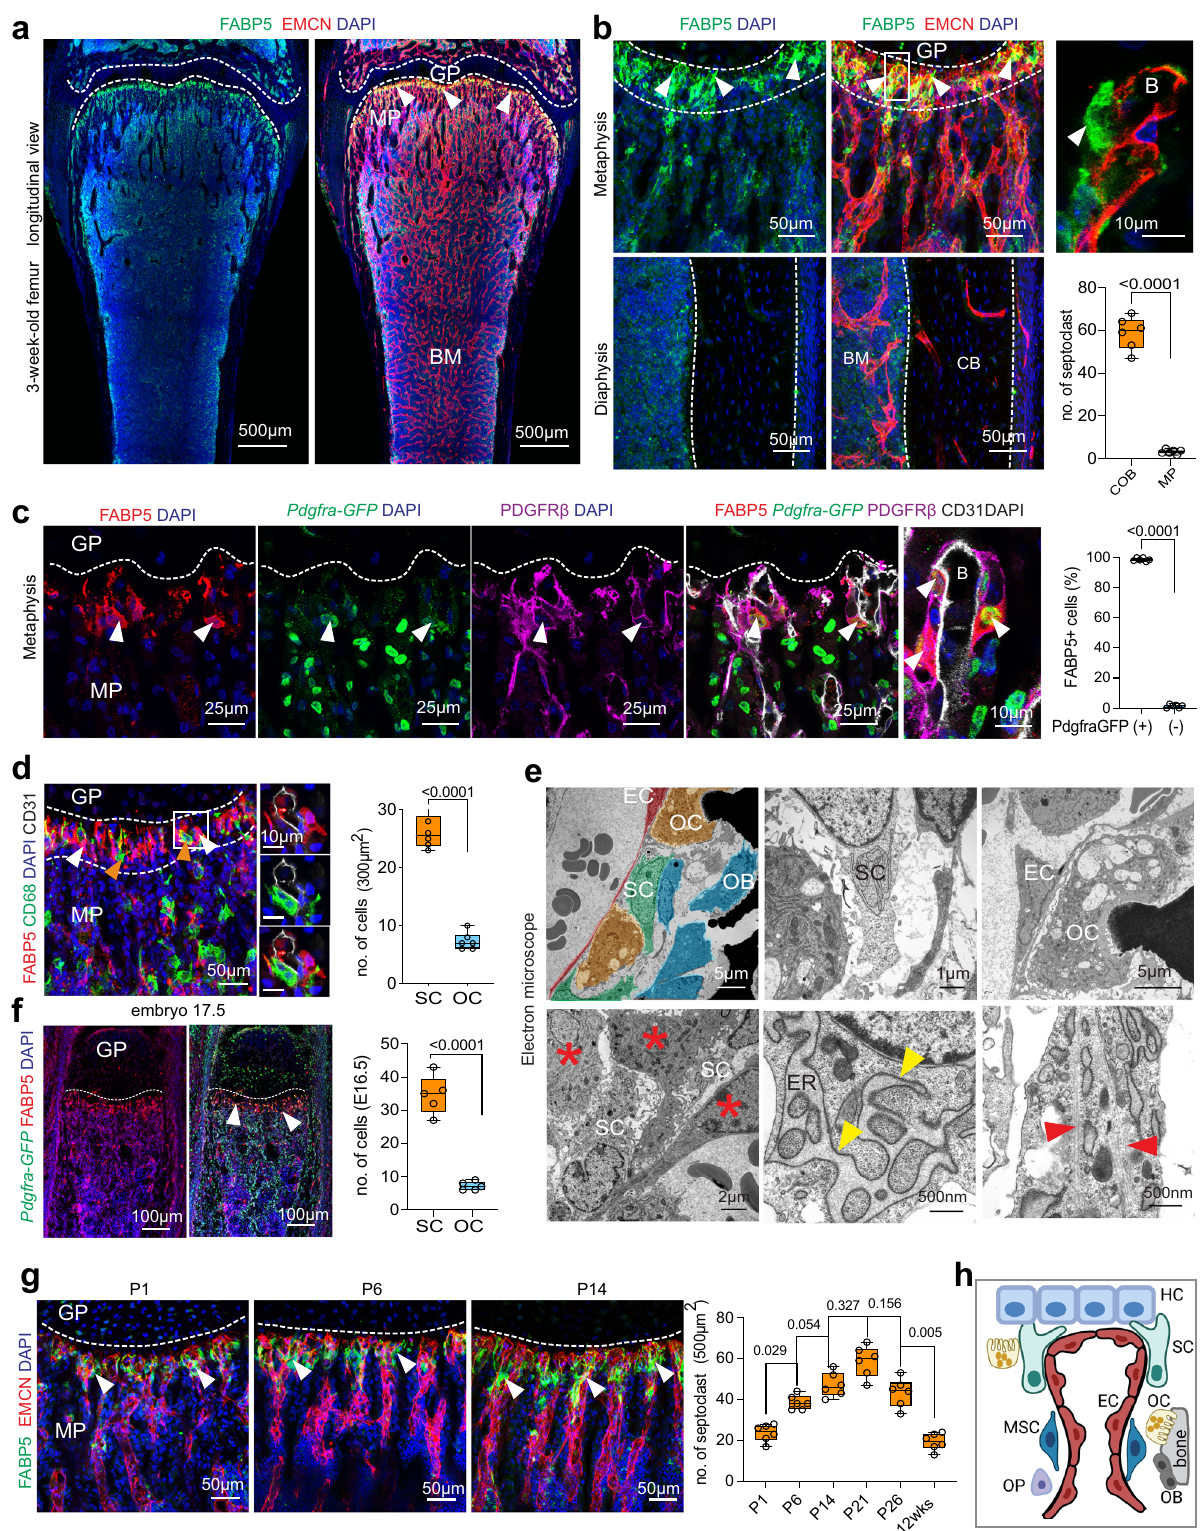
not labelled in Vav1-Cre R26-mTmG mice, which show wide- spread GFP expression in haematopoietic cells and therefore also in CD68 + osteoclasts (Fig. 2h and Supplementary Fig. 5c – f). These data indicate that FABP5 + cells at the chondro-osseous border, unlike osteoclasts, are not derived from the haemato- poietic lineage and, instead, emerge from PDGFR β + metaphyseal